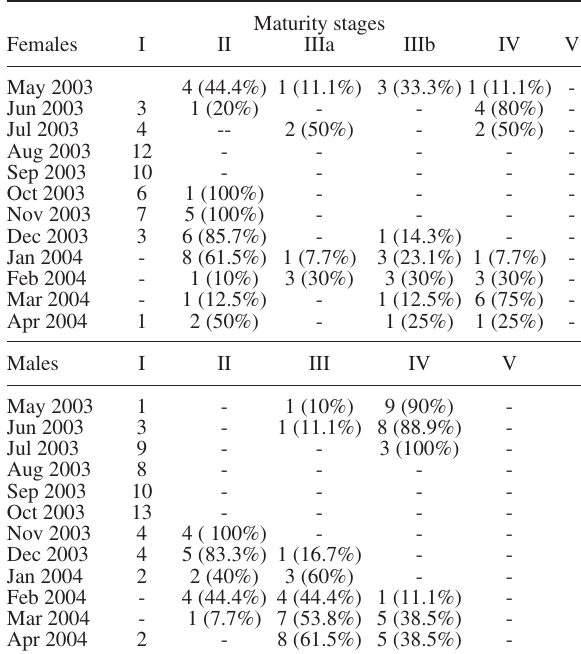
Table 2. – Specimens of Buenia affinis from the Kvarner area in each maturity stages by month of sampling: I, immature; II, devel- oping virgin and recovering spent; III, ripening (for females IIIa = early ripening and IIIb = late ripening); IV, ripe; V, spent. In paren- theses: number of females and males of maturity stages II-IV in pro- portion to total number of mature females and males for each month.